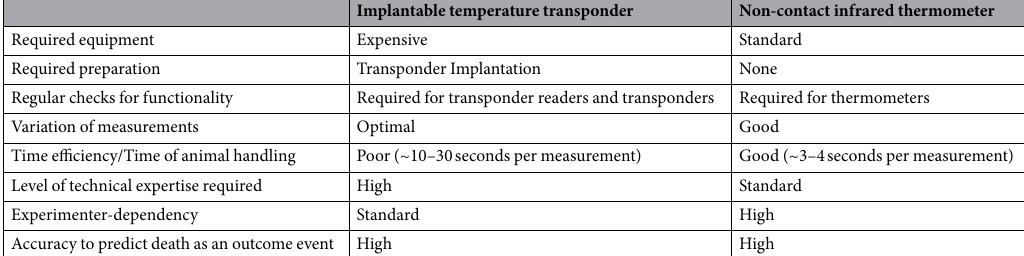
Table 2. Advantages and limitations of the two temperature measurement techniques assessed in the present